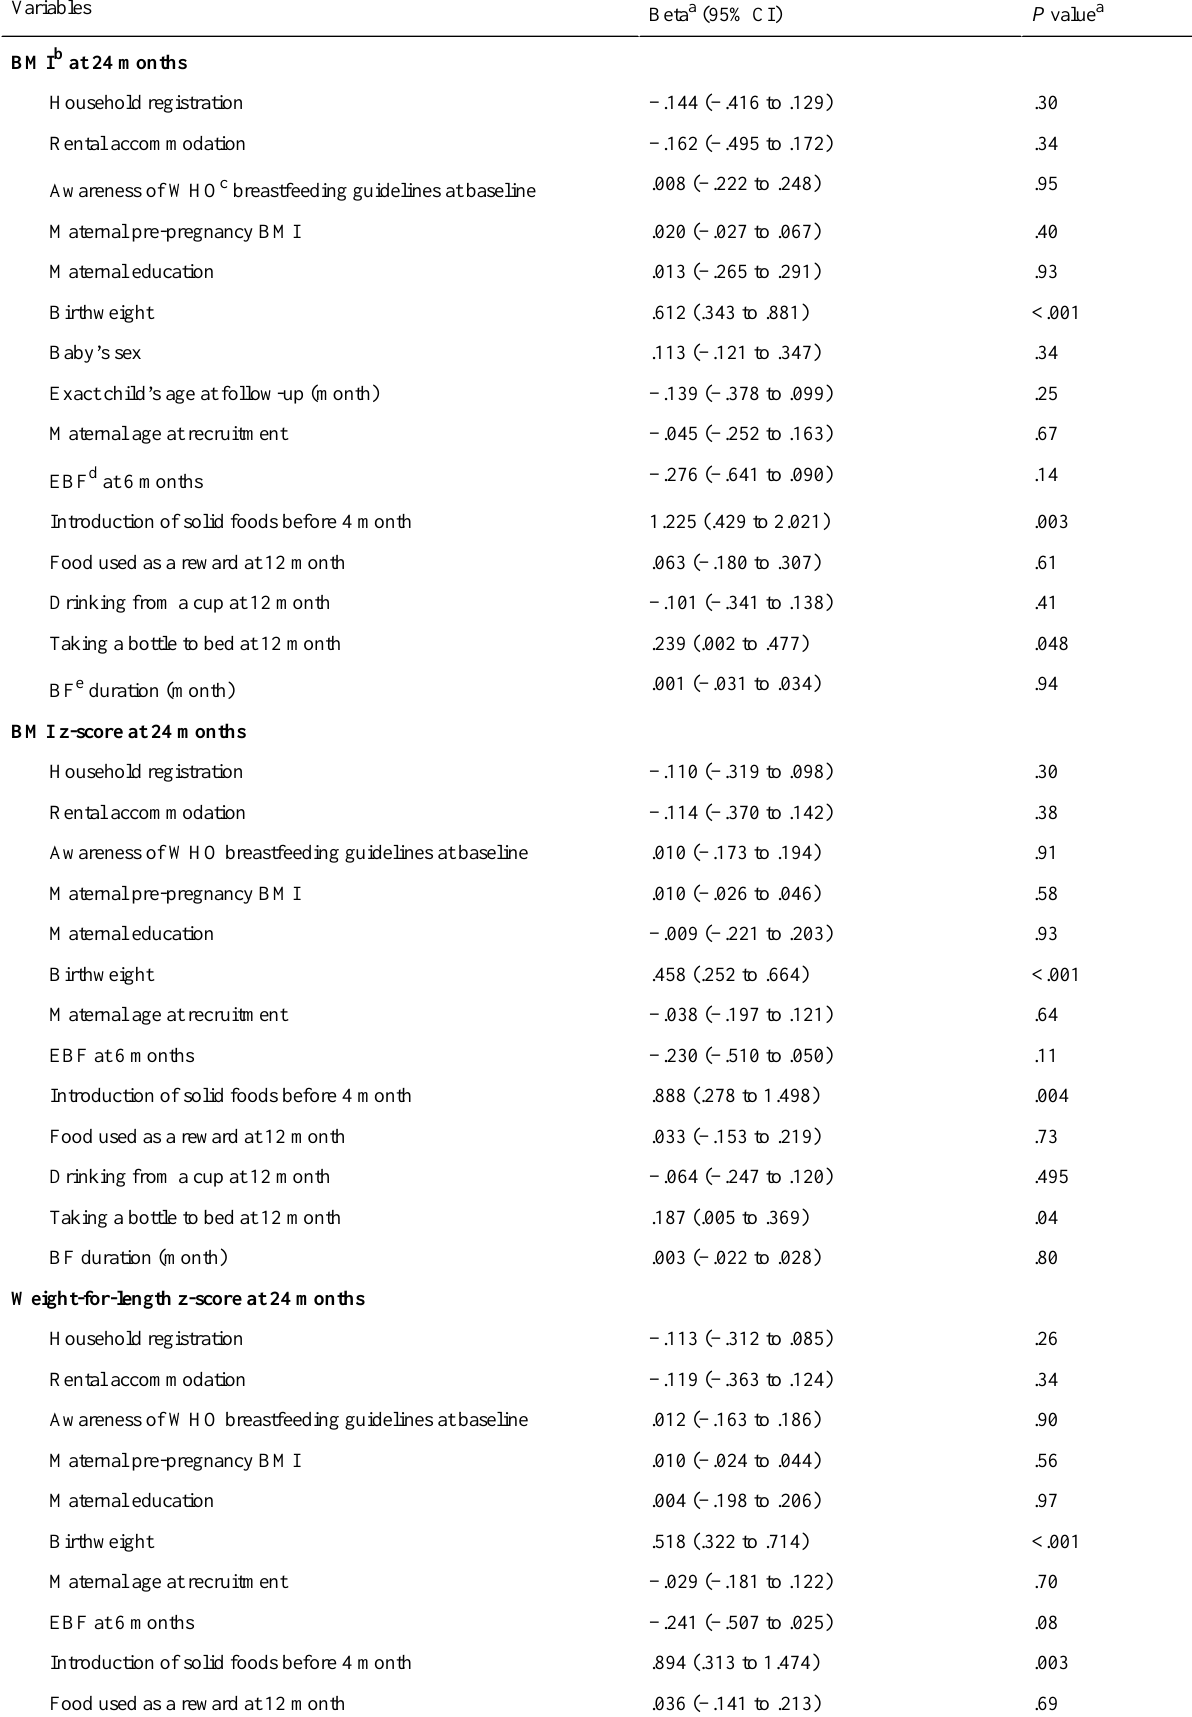
Table 1. Factors associated with body mass index (BMI) and BMI z-score at 24 months